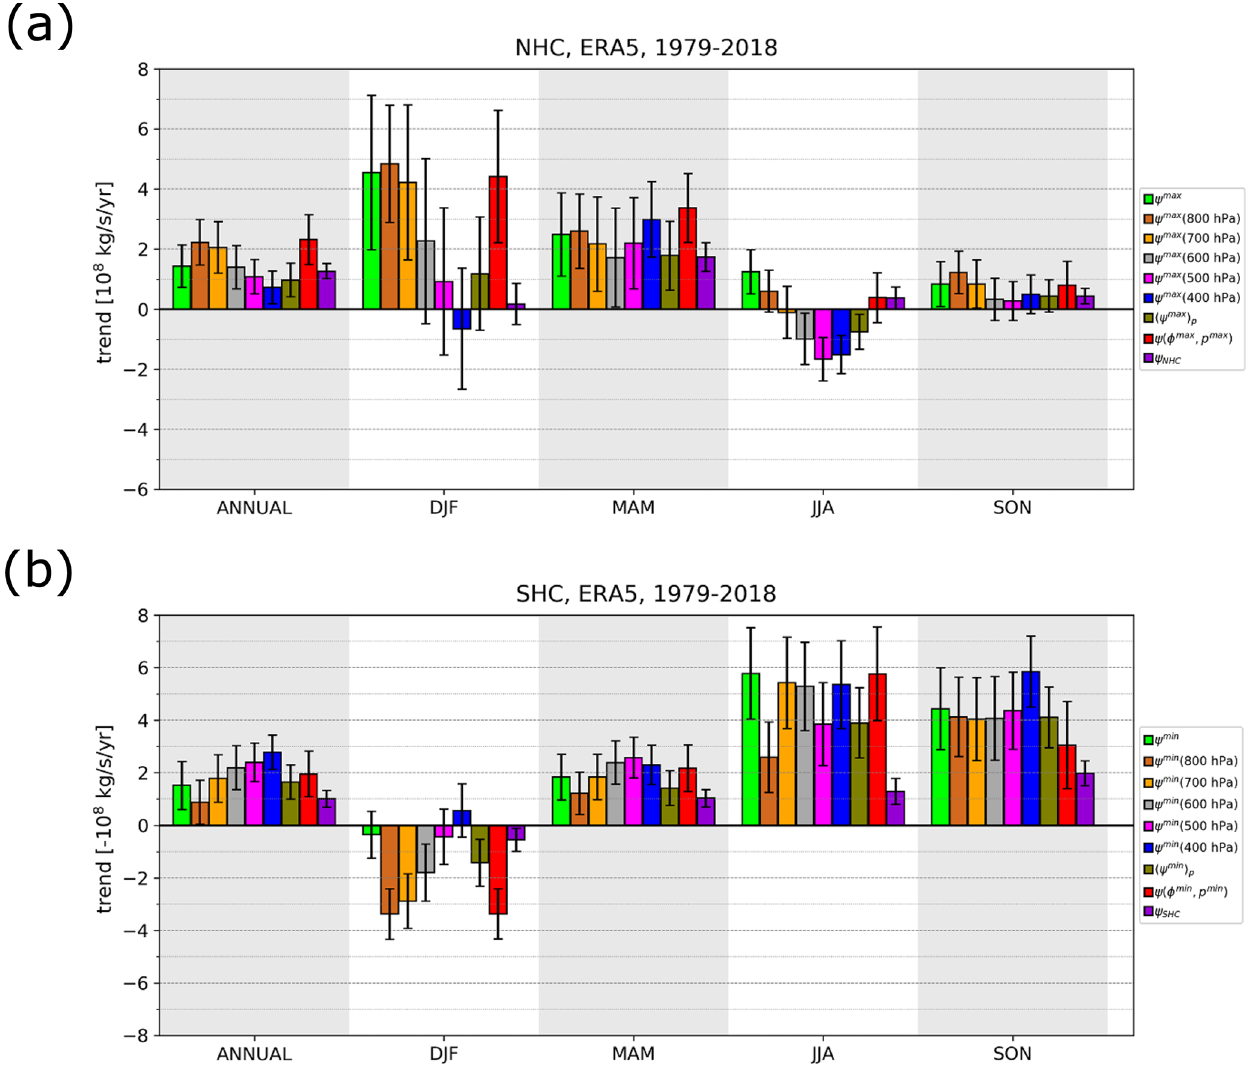
Figure 2. Trends in NHC strength (a) and SHC strength (b) in ERA5 reanalysis between 1979 and 2018 for different stream-function metrics from Sect. 2.2. Annual-mean trends in HC strength are shown in the first column, while seasonal-mean trends are shown in the other columns (as labelled). Different metrics of HC strength are shown in the legend, e.g. in (a) for the NHC: ψ max denotes annual/seasonal stream- function maximum (metric 1), ψ max at 400, 500hPa etc. denotes annual/seasonal stream-function maximum at respective pressure level (metric 2), and ψ (cid:0) ϕ max ,p max (cid:1) denotes that the trends are measured at the point of the maximum stream function in a multiyear average of NHC strength (metric 3). (cid:10) ψ max (cid:11) denotes vertically averaged ψ max between 200 and 900hPa (metric 4, Eq. 2) and ψ NHC denotes the p average stream-function metric (7), Eq. (3). Analogous notations are used for the stream-function minimum for the SHC in (b) . Note that values in (b) are multiplied by ( − 1 ) ; thus, positive values in both (a) and (b) indicate strengthening of the cell. Black error bars indicate the standard error of the trend